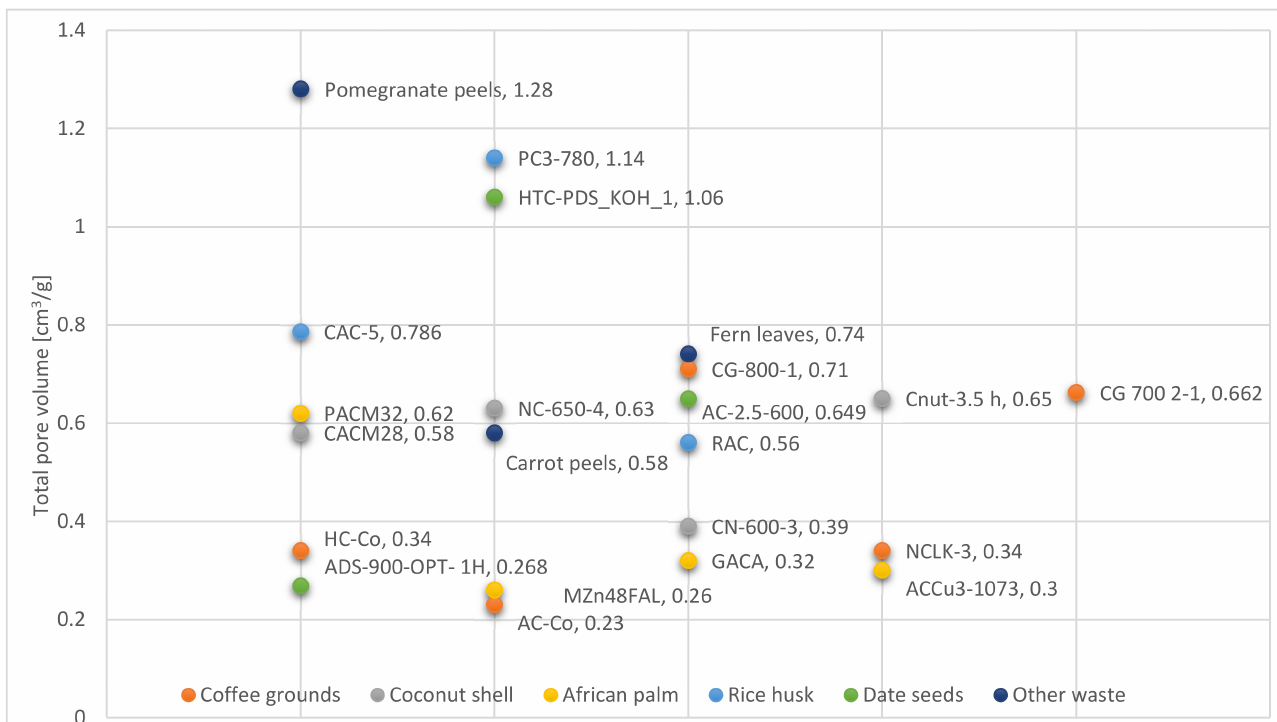
Figure 7. Total pore volume size distribution for bioadsorbents characterized in this literature